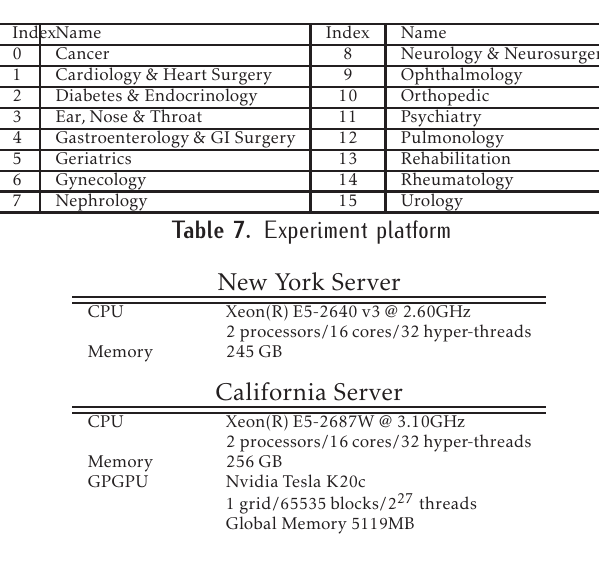
Table 5. Specialty catalog in the USNEWS dataset Table 6. Specialty catalog in the USNEWS dataset